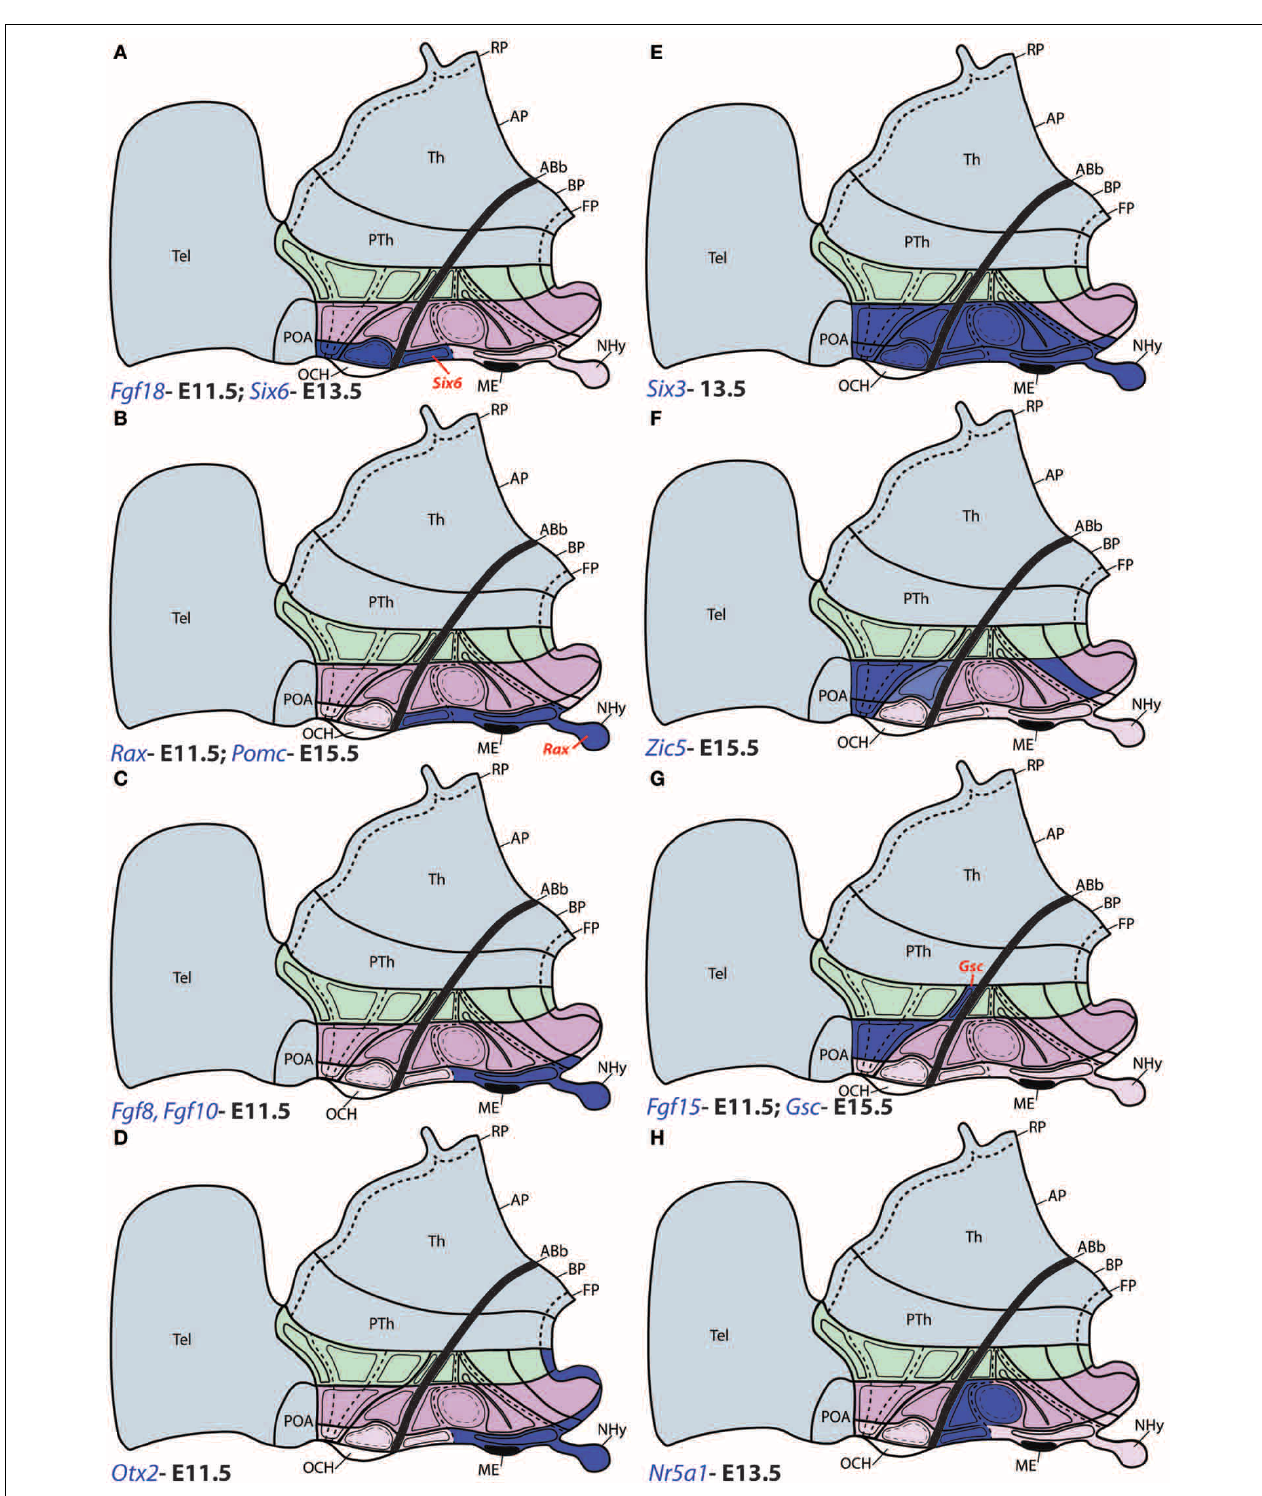
FIGURE 6 | Schematic maps of characteristic genoarchitectonic patterns in the hypothalamus, illustrating studied patterns selective for the acroterminal (ATHy), terminal (THy) or peduncular (PHy) hypothalamic domains. Compare subdivisions with Figure 1 . (A) The Fgf18 and Six6 domains overlap within alar ATHy domains; but only Six6 (red